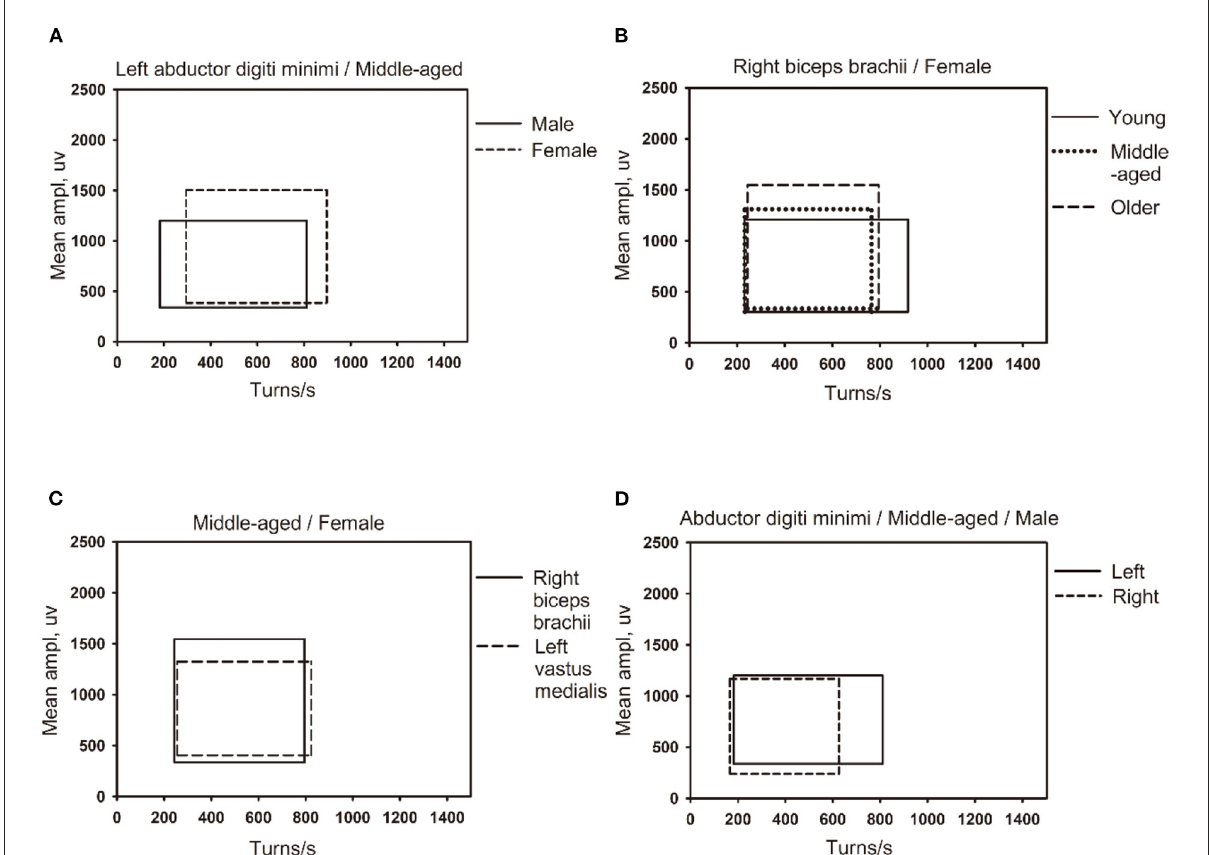
FIGURE4 The influence of different factors on the shape of the percentile clouds. (A) The clouds of different gender for same muscle (left abductor digiti minimi) in the middle-aged group (45–49 years old). (B) The clouds of different age groups for the same gender (female) in the same muscle (right biceps brachii muscle). (C) The clouds of different muscles (right biceps brachii and left vastus medialis) for the same gender (female) in the middle-aged group (45–49 years old). (D) The clouds of left and right muscles (left and right abductor digiti minimi) for the same gender (male) in middle-aged group (45–49 years